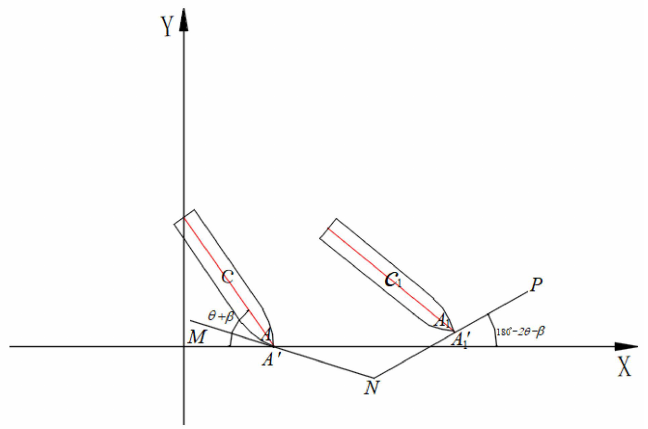
Figure 3. Diagram of the projectile trajectory in the ricochet process.